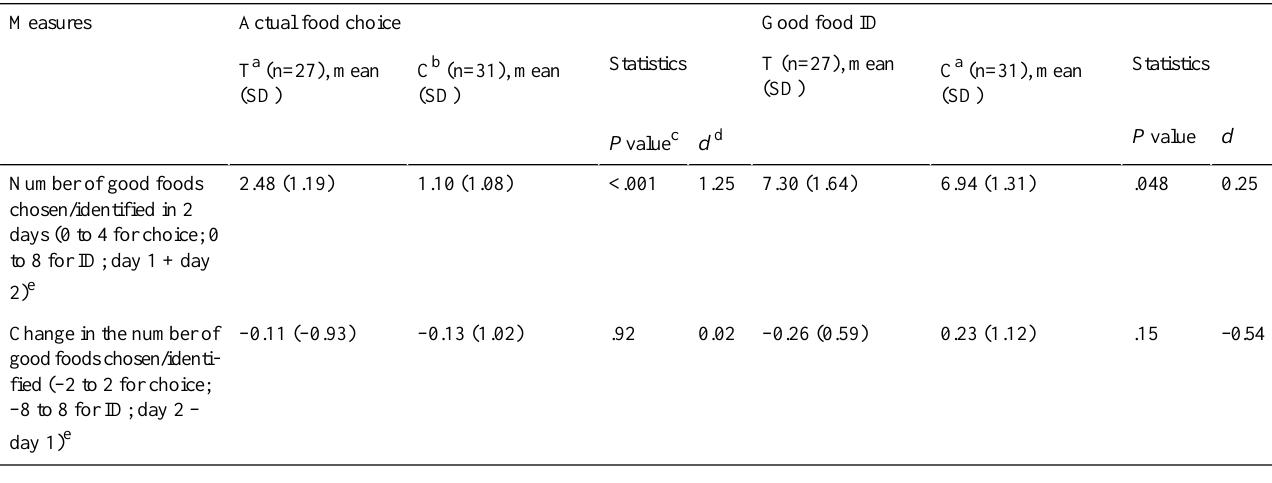
Table 4. Treatment effects on food choice and knowledge.